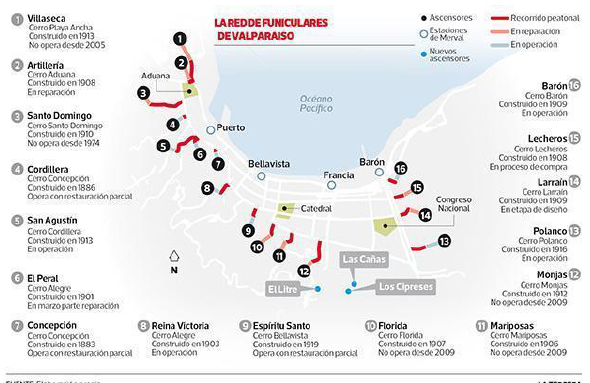
Figure 3. Valparaíso elevator plans. Source: Diario La